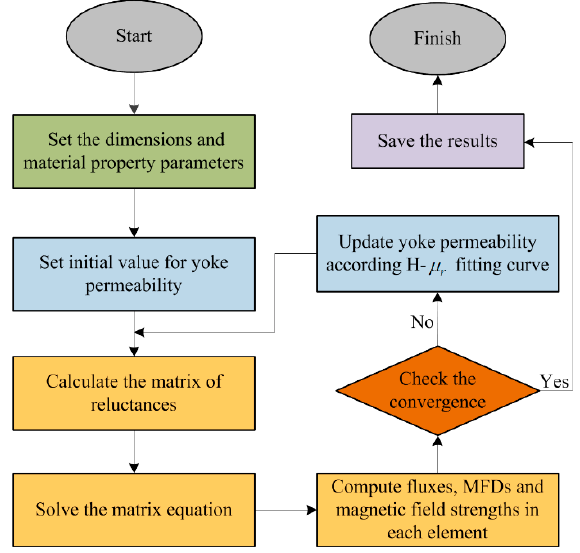
Figure 8. Procedures of the proposed iteration solving method.